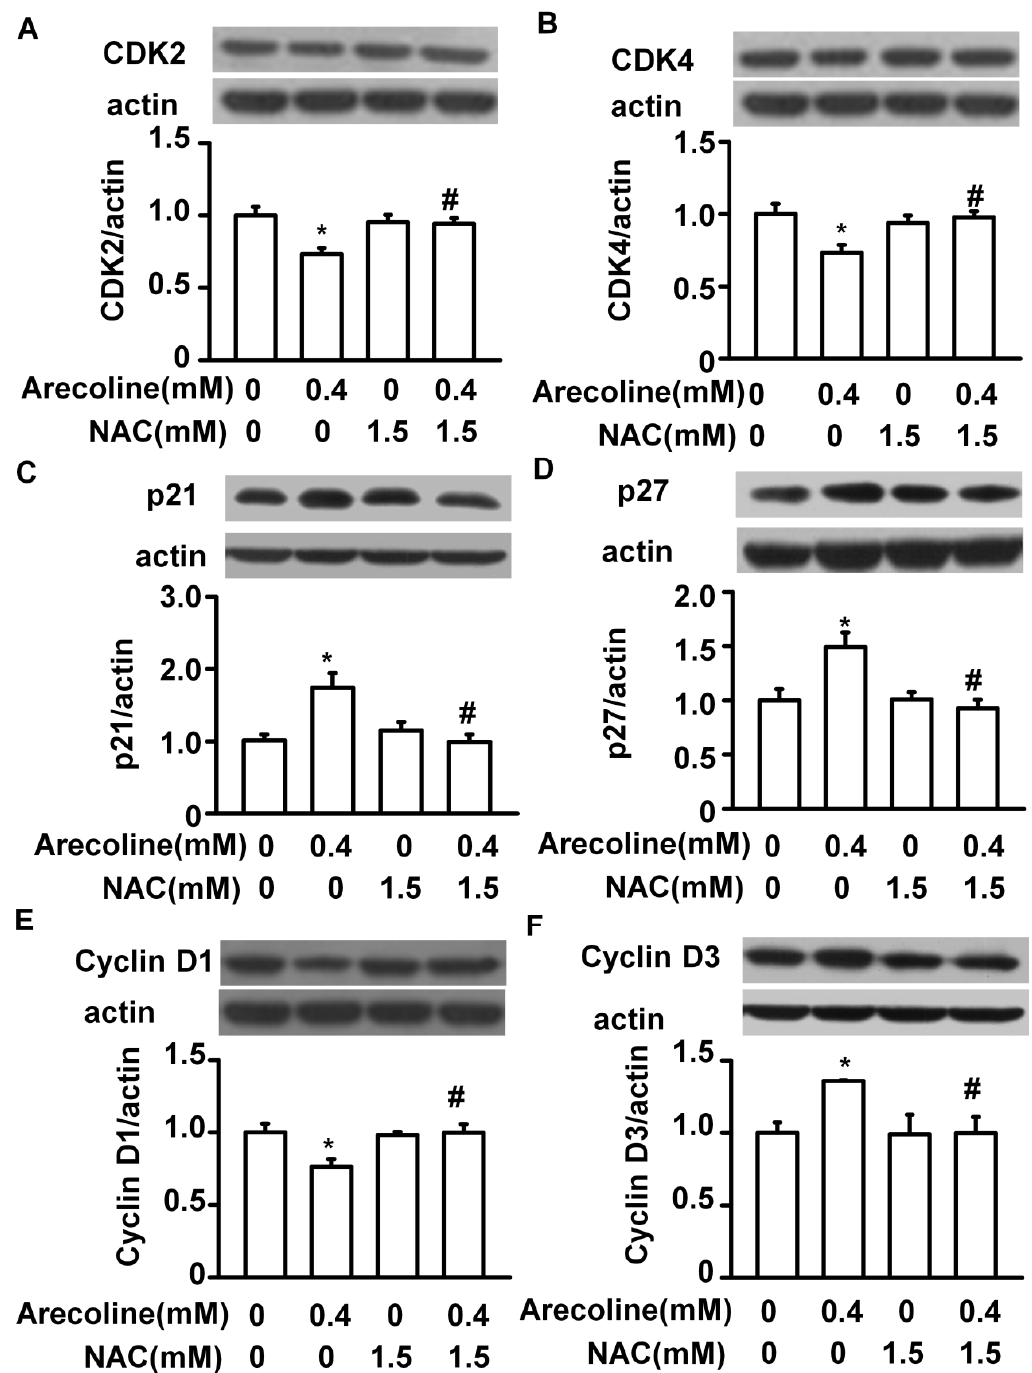
Figure 10. N-acetylcysteine (NAC) blocked the arecoline-induced alterations in the levels of cell cycle regulatory proteins, such as CDK2 ( A ), CDK4 ( B ), p21 ( C ), p27 ( D ), Cyclin D1 ( E ) and Cyclin D3 ( F ) in androgen-dependent human LNCaP prostate cancer cells. Cells were pretreated with NAC for 1 h and then exposed to 0.4 mM arecoline. After 24 h of treatment, the protein levels were examined by Western blot analysis and were then expressed after normalization to actin expression. Data are expressed as the mean ± SEM from triplicate experiments; each result was pooled from the data of four 10 cm culture plates. * p < 0.05 vs. the control; # p < 0.05 arecoline vs. NAC + arecoline. Generally, CDK1 and CDK2/CDK4/CDK6 control the checkpoints of the G2/M phase and the G0/G1 phase, respectively, p21 and p27 act as endogenous inhibitors of CDKs, and cyclin B1 and cyclin D function as the endogenous activators of CDK1 and CDK4/6, respectively [16,17]. Increased